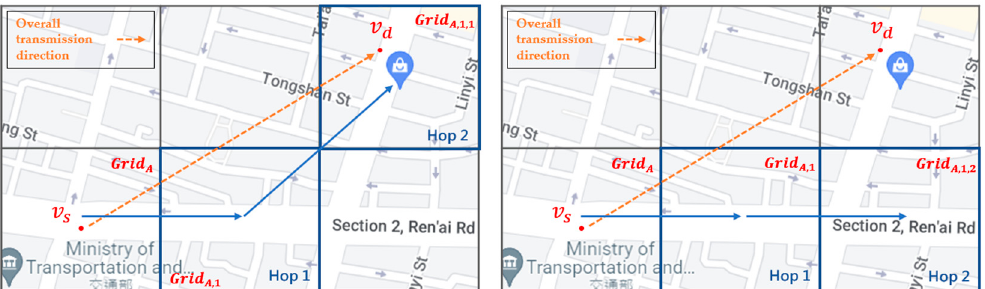
Figure 9. An example of the two-hop next grid in SD-QGrid.